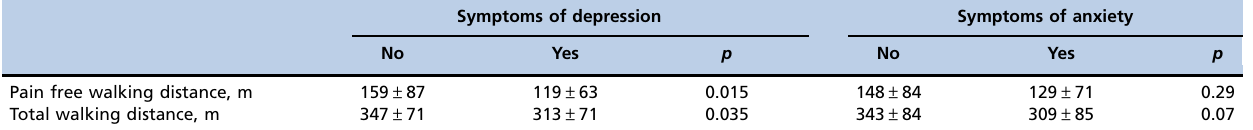
Table 2 - Walking capacity according to the presence of depressive and anxiety signs.